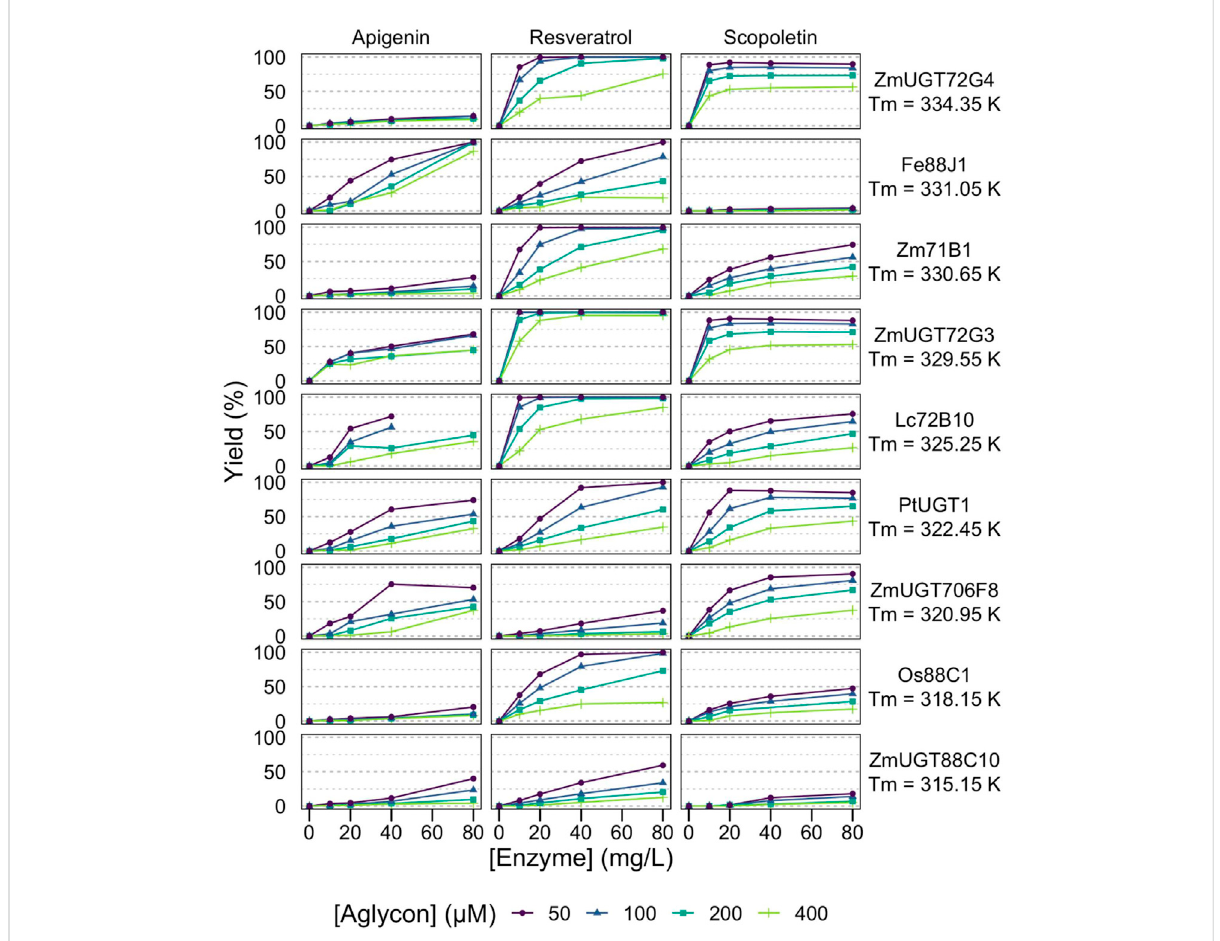
FIGURE 3 Effect of reaction conditions on glycosylation yields from high- T m enzymes. Analytic yields of acceptor conversion are plotted against enzyme concentration, from 10 to 80 mg/L (circa 0.15 – 1.2 μ M). HEPES pH 7, aglycon concentration range 50 – 400 μ M, UDP-Glc 500 μ M, 20 h at 293 K, without stirring in 100 μ L